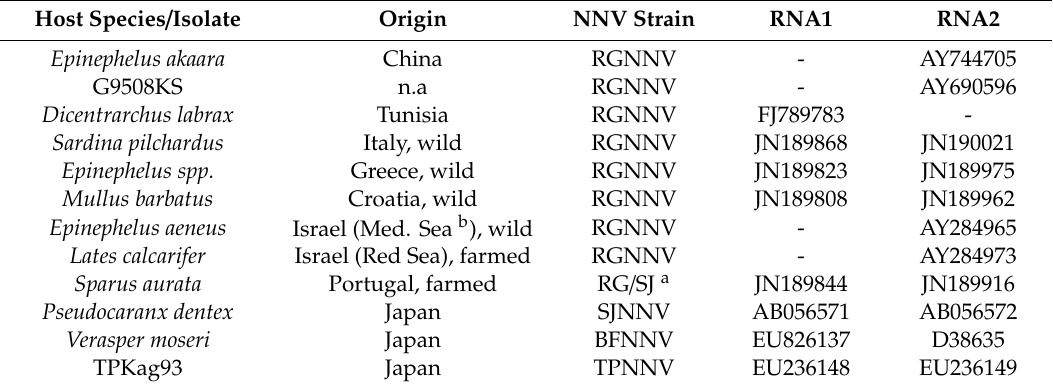
Table 1. List of NNV isolates used in the phylogenetic analysis. Host fish species or isolate number, Country and origin, wild or farmed, viral strain, and accession numbers in